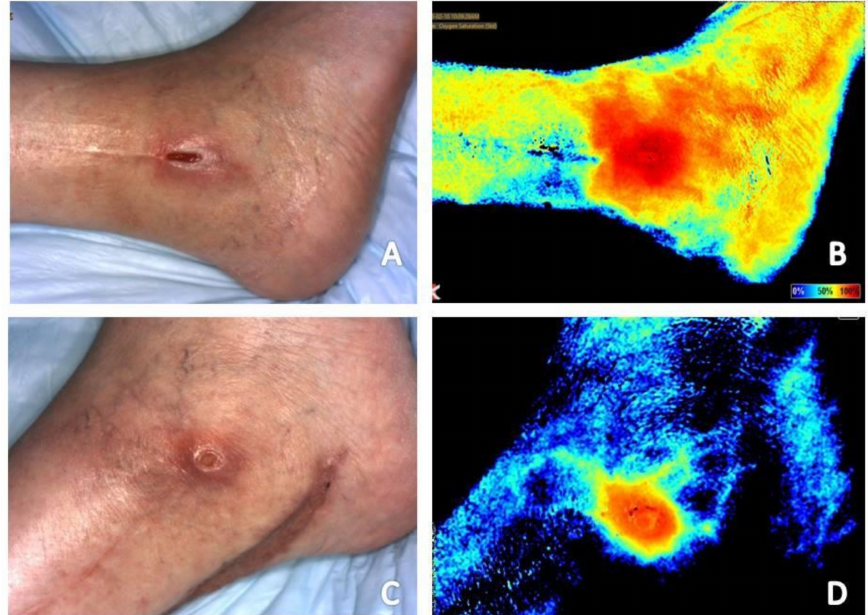
Figure 5. ( A ) Baseline clinical photograph; and ( B ) near-infrared image assessment of the right lateral ankle. The patient had undergone open reduction and internal fixation of an ankle fracture which was subsequently complicated by osteomyelitis. Note on the baseline near-infrared image ( B ) the increased signal in the area of the distal fibula incorporating and extending beyond the wound bed. ( C ) Clinical photograph; and ( D ) near-infrared image assessment following surgical intervention consisting of debridement, skin and soft tissue flap for closure, and antibiotic therapy. Note the reduction of signal on the near-infrared image, with localization only to the area of the wound, indicting resolving infection and a wound in the proliferative phase of